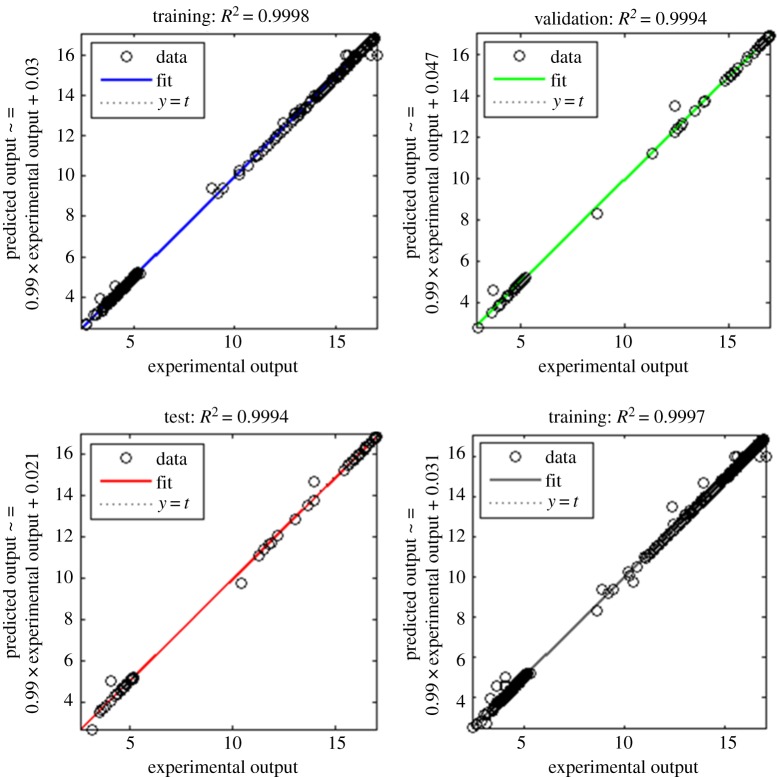
Experimental result versus ANN predicted output.